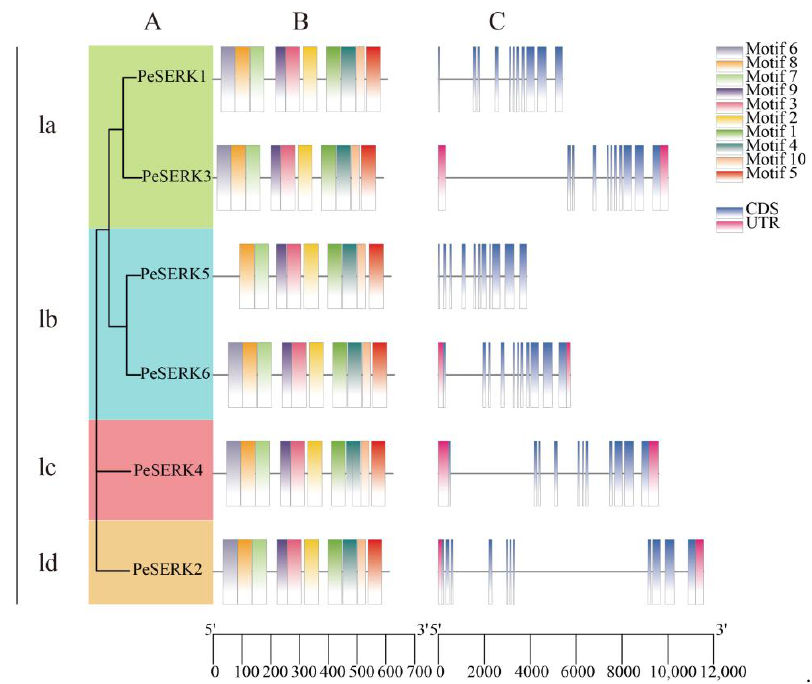
Figure 3. Phylogenetic relationships, motif compositions, and gene structure of moso bamboo Pe- SERKs. ( A ) Phylogenetic tree and classification of PeSERK proteins. PeSERKs can be divided into four clades. ( B ) Schematic representation of the motifs among PeSERK proteins obtained by MEME analysis. Each color represents a specific motif. ( C ) Exon/intron organization of PeSERKs . Exons, introns and untranslated regions are represented by orange boxes, fold lines and purple boxes, re- spectively.